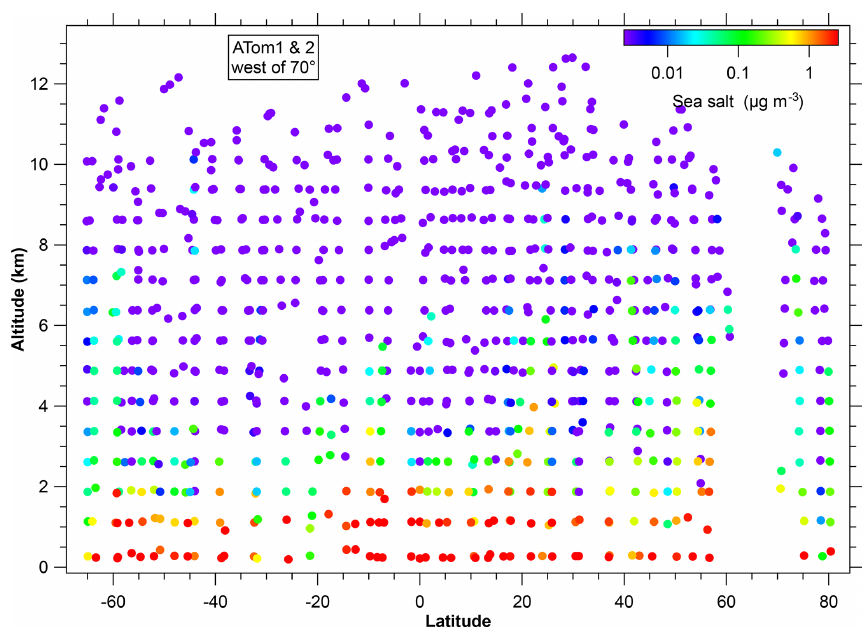
Figure 3. Concentration of sea-salt aerosol during the ATom1 and ATom2 flights over the Arctic, Pacific, and Southern oceans. The blank region between about 60 to 70 ◦ N is because of flying over land (Alaska). The color scale is from 2.5ngm − 3 to 2.5µgm − 3 (at standard conditions). These concentrations include sea-salt particles between about 180nm and 3µm diameter. Data are averaged over bins of 750m vertically and about 4 ◦ latitude; points are plotted at the midpoint location of the data within each